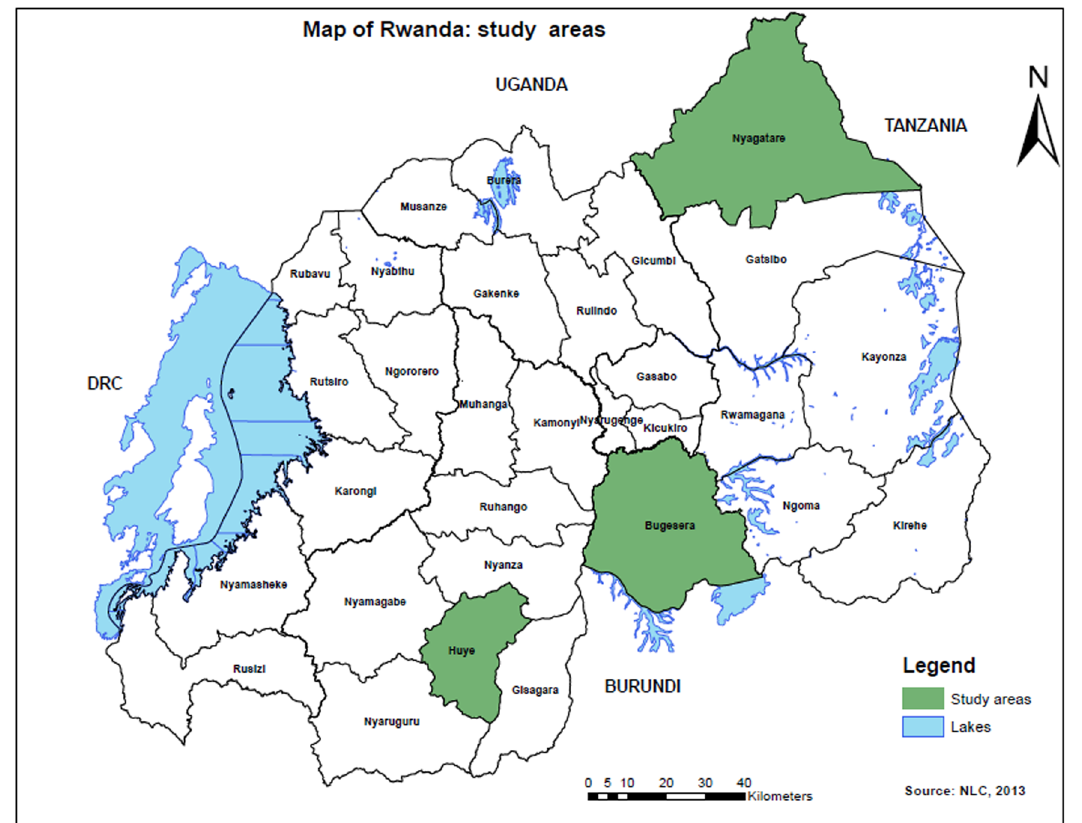
Figure 1: Map of Rwanda showing the study